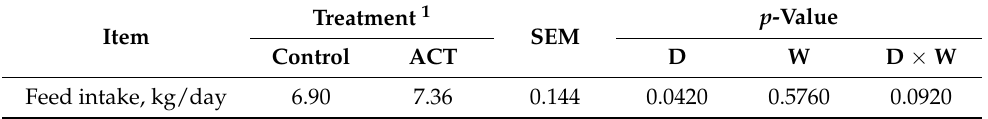
Table 2. Average dry matter intake (DMI) of dry cows.